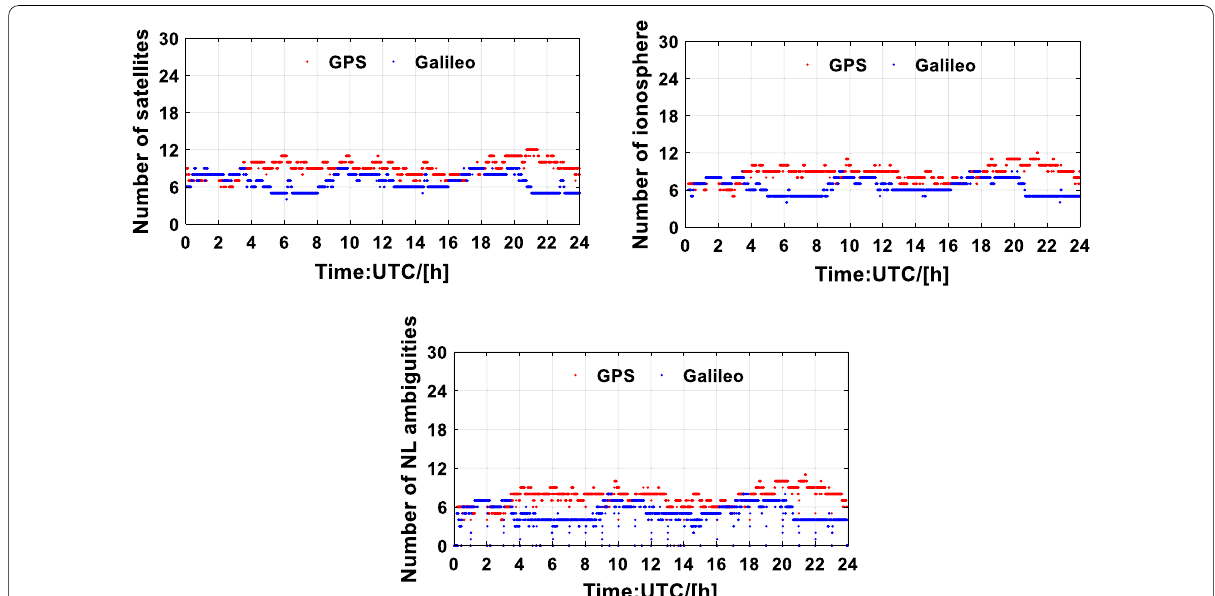
Fig. 11 Number of satellite, number of fixed SD NL ambiguities, and number of estimated ionospheric delays from MNAN station on DOY 082,